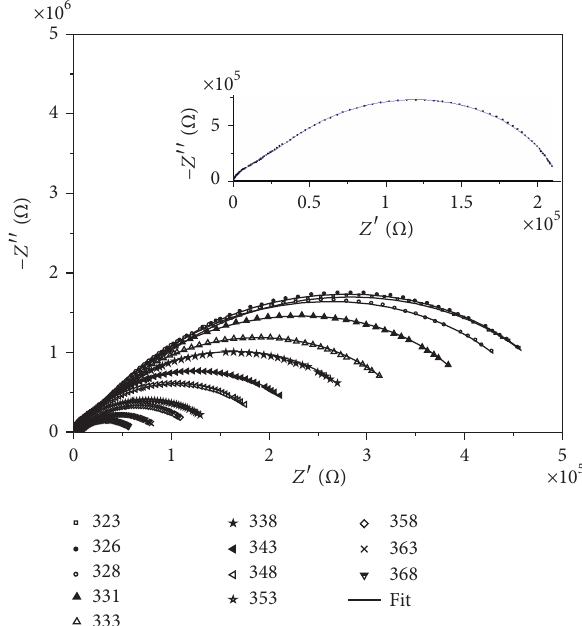
F 5: Impedance spectra of [(C sample at dif- ferent temperature. e inset shows the plot of ( 338K.